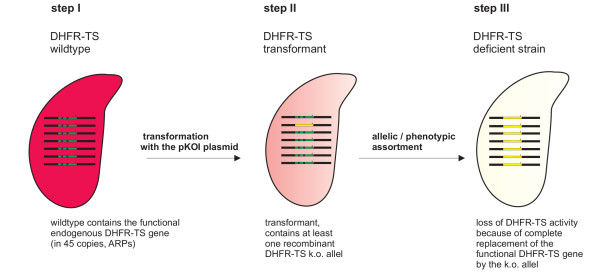
Generation of DHFR-TS deficient strains by allelic assortment. Wildtype strains are transfected with pKOI. In one copy of the 45 ARPs the endogenous DHFR-TS gene is substituted by the knock out construct (step 2). By amitotic division of the MAC and increasing selection pressure clones will arise, that have sorted out all endogenous DHFR-TS genes and retain only recombinant and defect DHFR-TS genes (step 3).